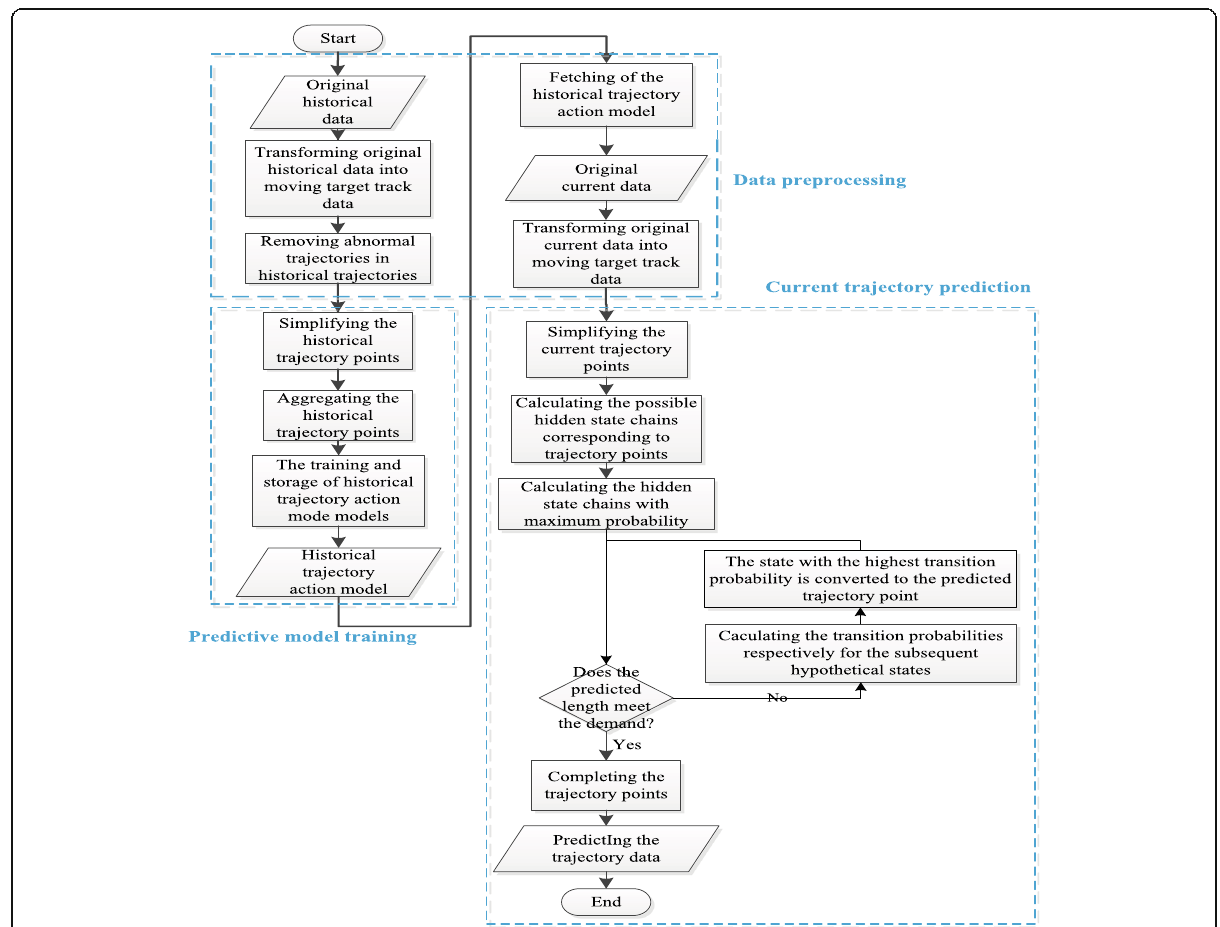
Fig. 1 Trajectory prediction method flow